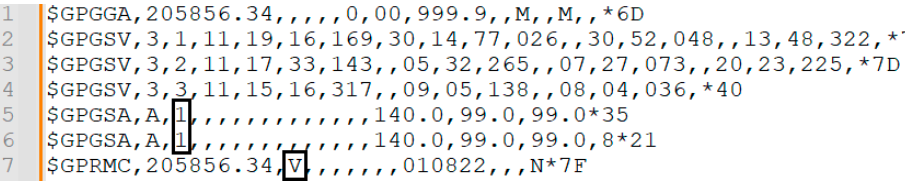
Figure A2. File after filtering.